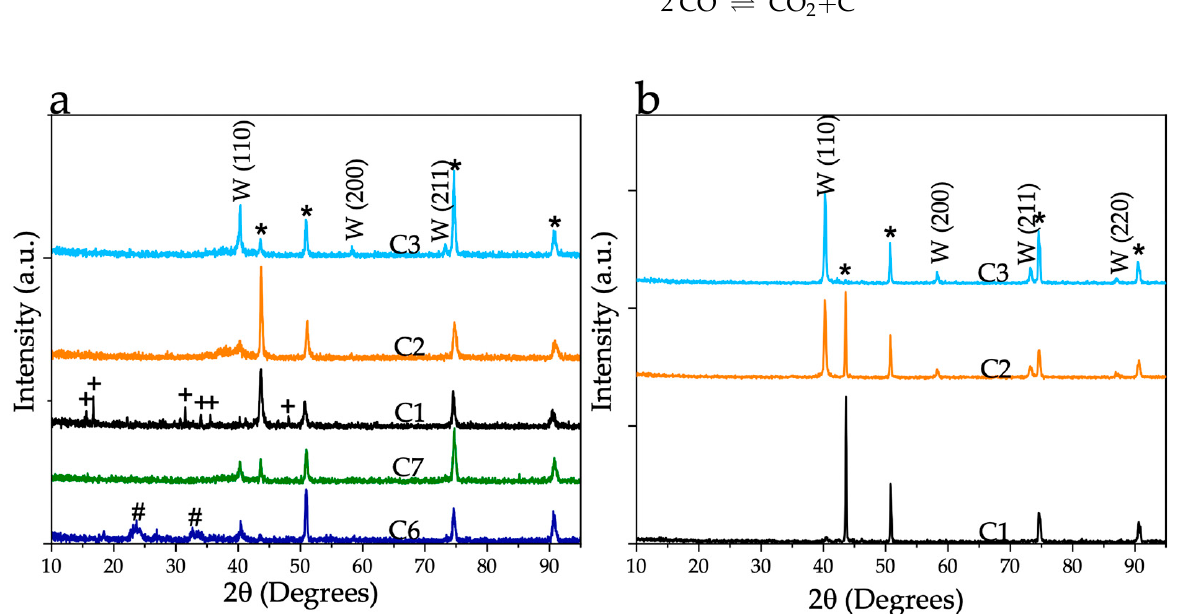
Figure 4. XRD of the samples converted at different energy densities: ( a ) as-converted samples and ( b ) heat-treated in vacuum at 900 °C for 1 h (* denotes Inconel 625 substrate; # denotes WO x peaks; + denotes W(CO) 6 peaks).